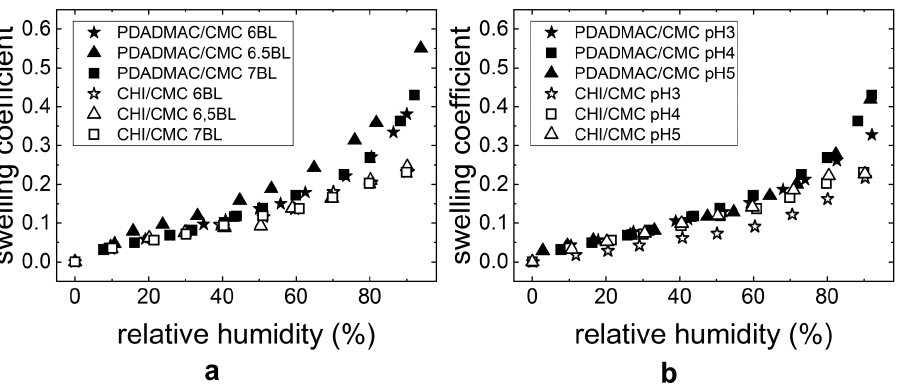
Figure 7. The swelling coefficient S dependent on the relative humidity RH of the PEMs PDAD- MAC/CMC and CHI/CMC with ( a ) varying NoBL (at pH = 4) and ( b ) different pH-values (seven BL). The thicknesses were measured by